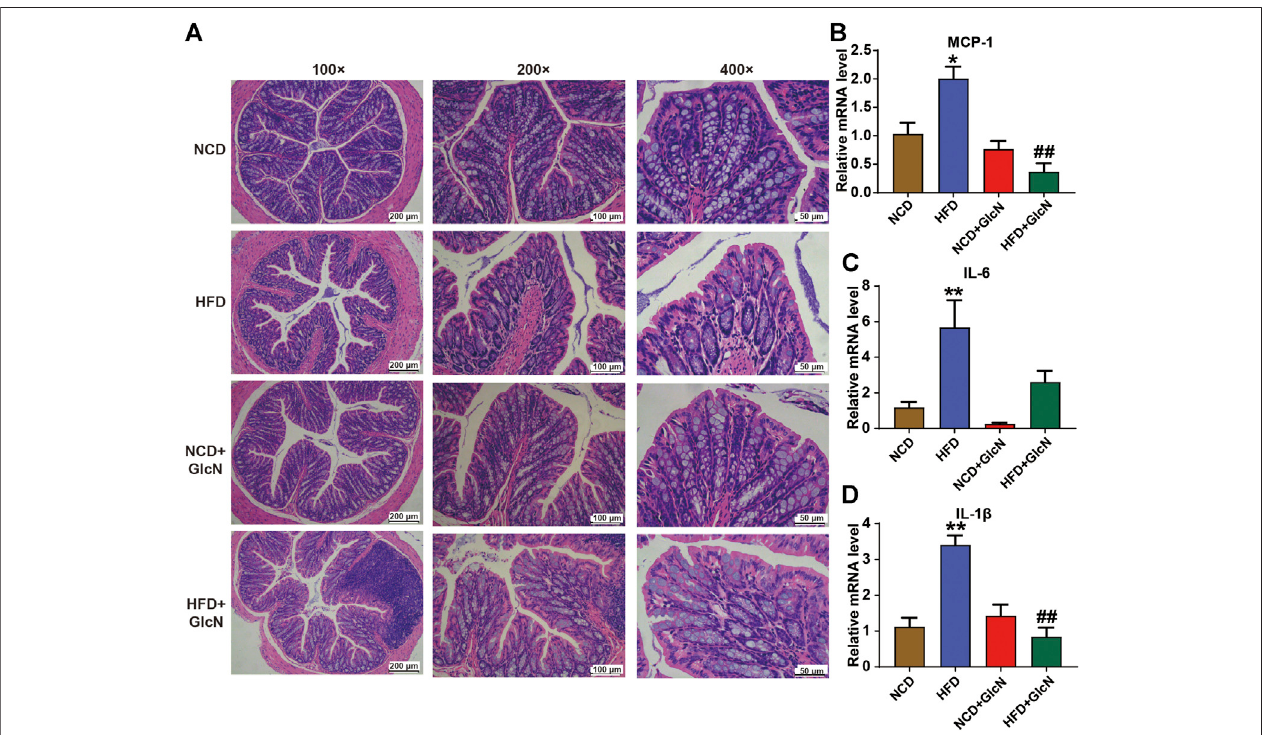
FIGURE 7 | GlcN suppressed in fl ammatory responses in colon tissues of HFD-fed mice. After the treatment with NCD, HFD, and/or GlcN (1 mg/ml, in drinking water)for5 months,allmiceweresacri fi ced.ThecolontissueswerestainedbyH&Eandphotographedunderamicroscope(magni fi cationof × 100, × 200and × 400) (A) . TheexpressionsofMCP-1 (B) ,IL-6 (C) ,andIL-1 β (D) incolonatmRNAlevelweredetectedbyqRT-PCR.Datawereshownasmeans ± SEM( n (cid:1) 5).* p < 0.05indicates the difference between HFD group and NCD group; ## p < 0.01 indicates the difference between HFD + GlcN group and HFD